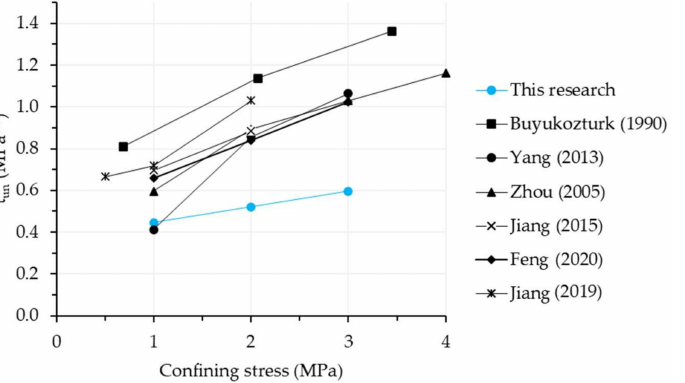
Figure 21. Maximum normalized shear stress in single-keyed dry joints obtained for specimens from ordinary (black lines) [13,30,40,41,43,44] and RAC (blue